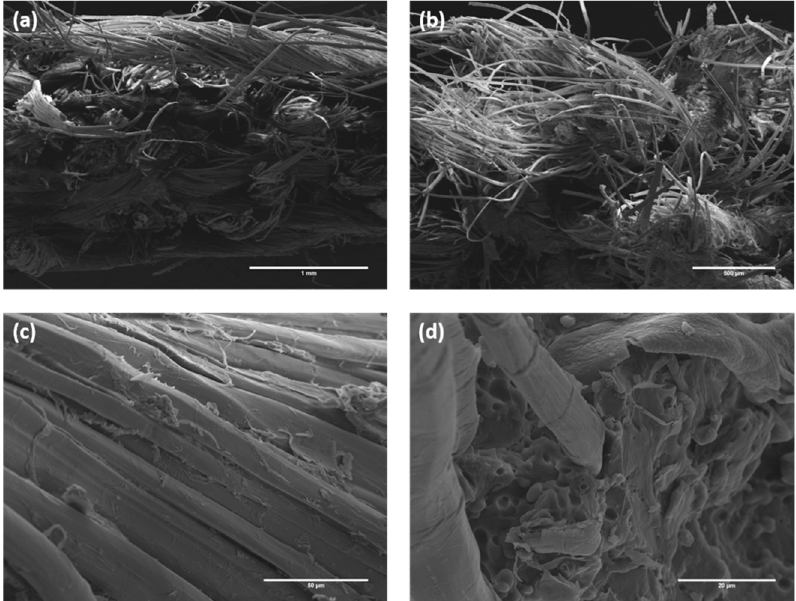
Figure 5. SEM micrographs of the fracture surfaces of PP/Flax composites at different magnifications. Polymers 2020 , 12 , 438